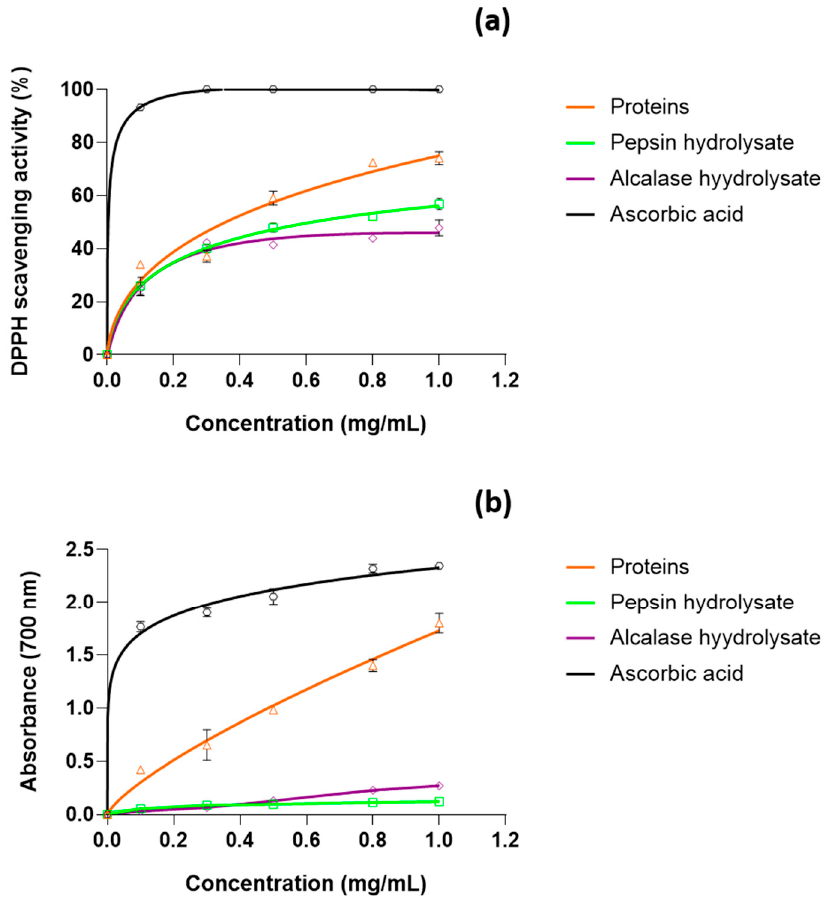
Figure 4. Antioxidant activities of proteins and peptide hydrolysates using ( a ) DPPH radical-scavenging assay and ferric reducing power assay ( b ).